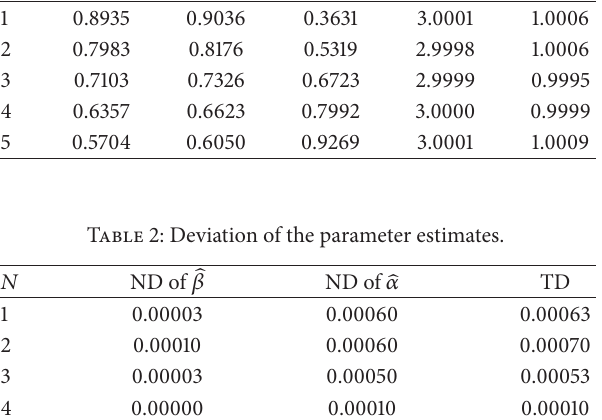
Table 1: Computation table for CV 𝑒 ,